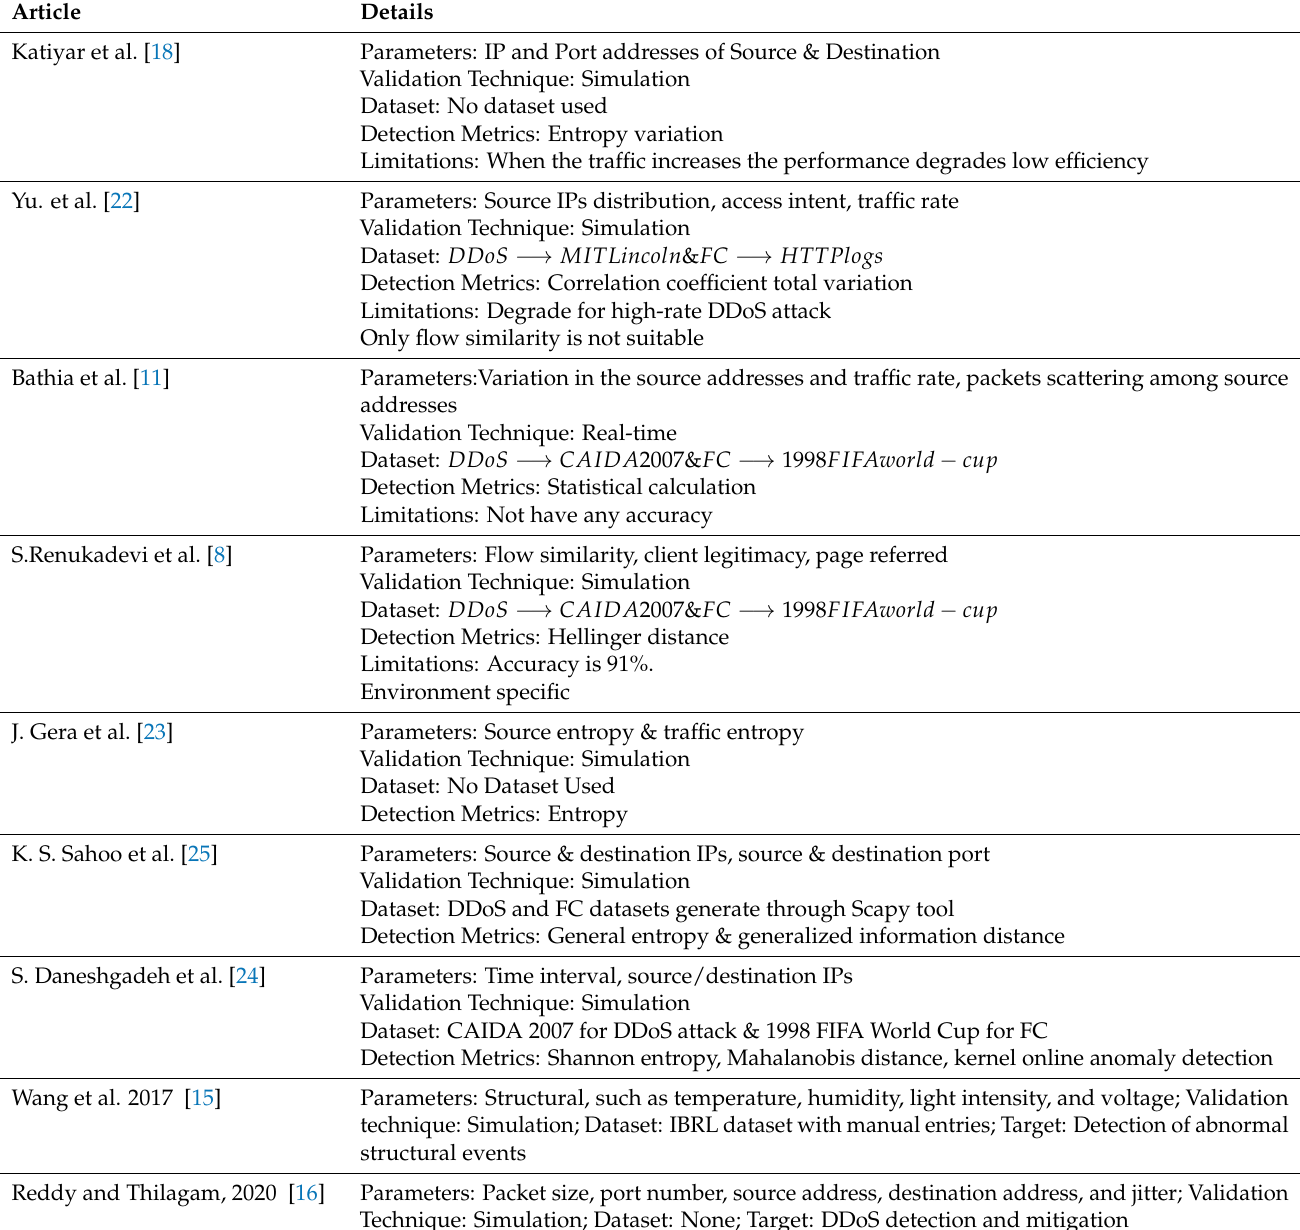
Table 1. Summary of related